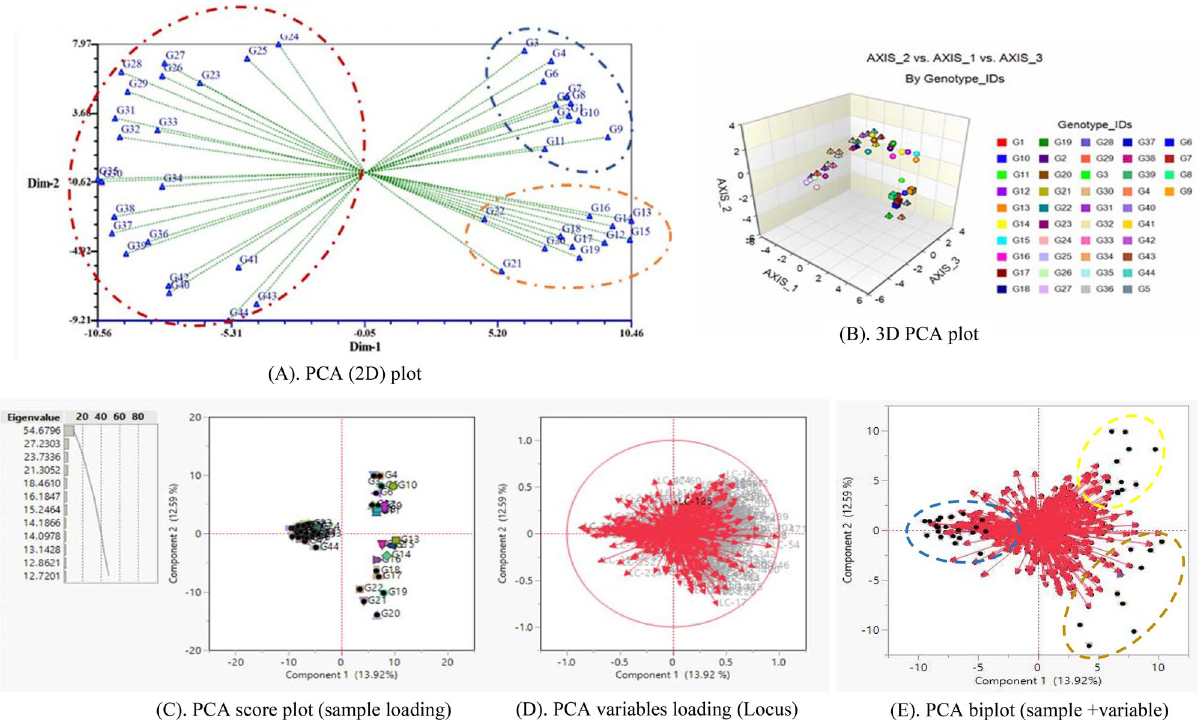
Figure 7. (A) PCA (Euclidian’s measure) case scores using NTsys program; (B) three-dimensional (3D) graphical display of PCA 3D was generated by using NCSS 2021; (C) PCA score plot (sample loading); (D) PCA variables loading (loci); and (E) PCA biplot representing the loci (red vector) and sample (accessions) loading based on ISSR markers using JMP ver. 16